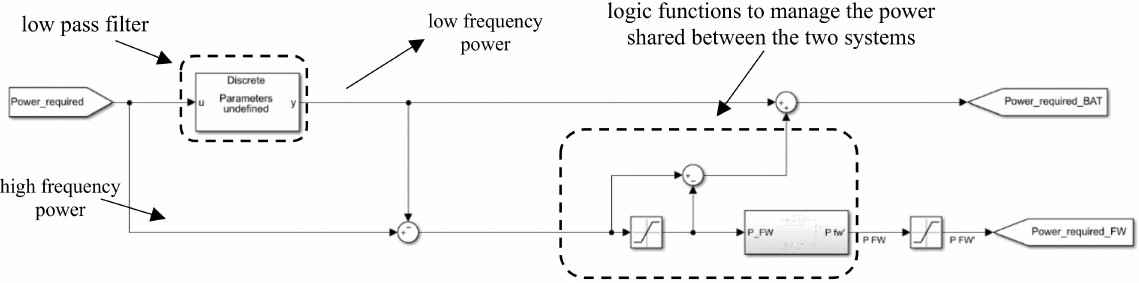
Figure 13. Power control of the hybrid storage